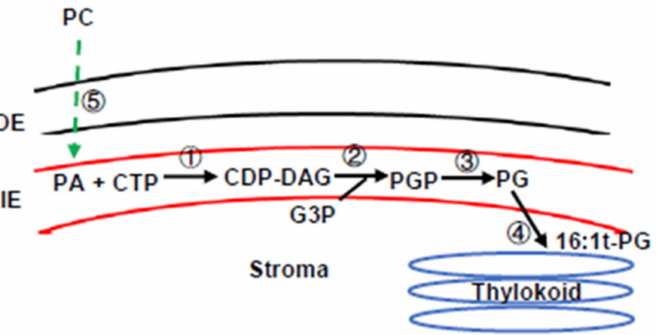
Figure 1. A diagram presentation of plastid PG synthesis in Arabidopsis . OE, chloroplast outer envelope mem-brane; IE, chloroplast inner envelope membrane; PA, phosphatidic acid; CTP, cyti- dine trios phosphate; CDP-DAG, cytidine diphosphate-diacylglycerol; G3P, glycerol-3-phosphate; PGP, phosphatidylglycerol phosphate; PG, phosphatidylglycerol; 1 (cid:13) , CDP-DAG synthase; 2 (cid:13) ,